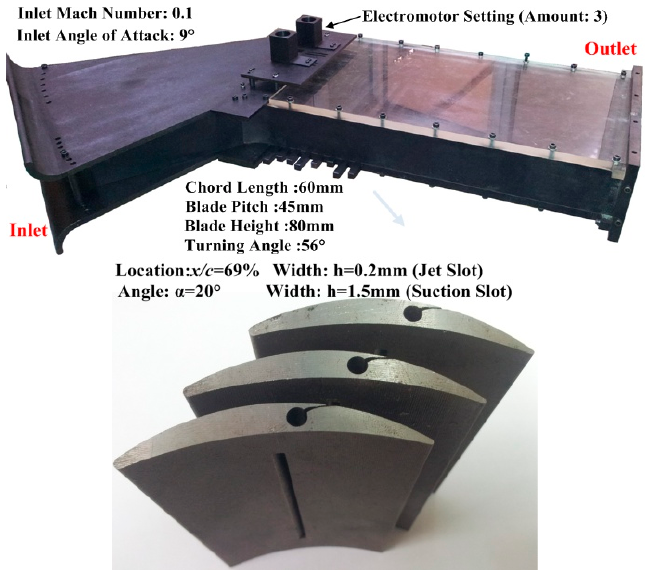
Figure 20. Experimental system and blades with slots.